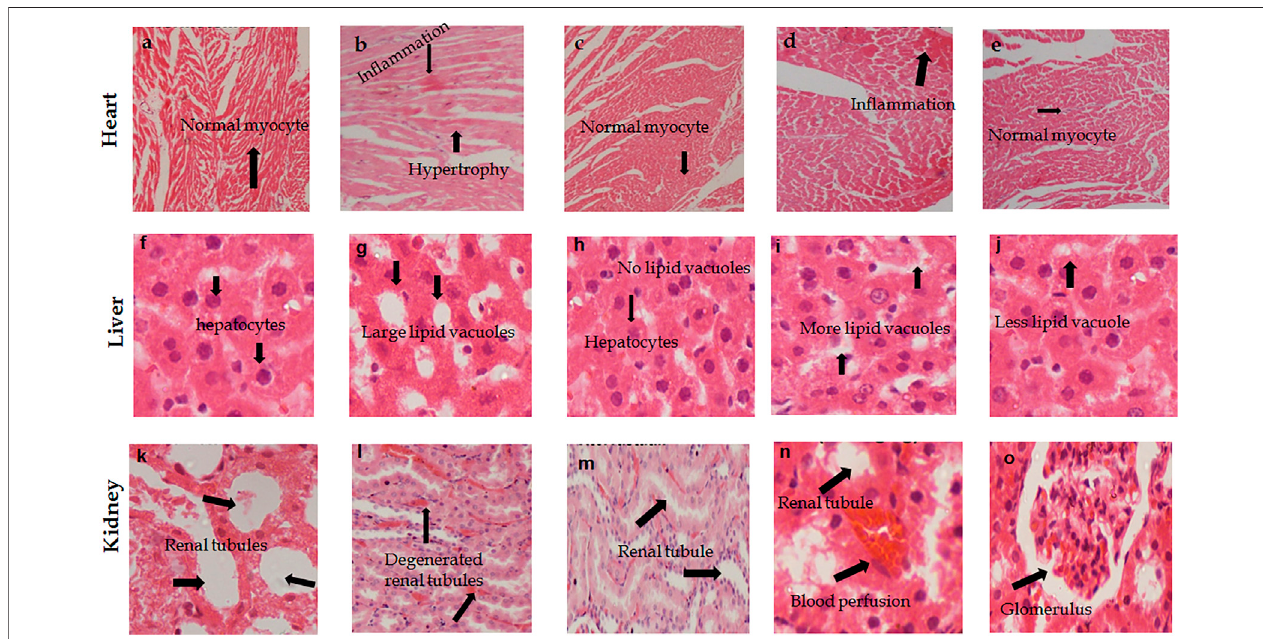
FIGURE4| PhotomicrographsH&Estainedtissuesectionsofheart,kidney,andlivershowingtheeffectof( A.of fi cinarum )AOtreatmentinchronicobesogenicdiet-fed hypertensiverats. (A,F,K) Normotensiverats, (B,G,andI) hypertensiverats (cid:1) highfat,sucrose,andsalt(HFSS)diet, (C,H,andM) HFSS+atorvastatin(10 mg/kg,peroral)- treated rats, (D, I, and N) HFSS + AO (250 mg/kg, per oral)-treated rats (E, J, and O) HFSS + AO (500 mg/kg, per oral) treated rats. 400 X, scale bar displays 50 μ m.